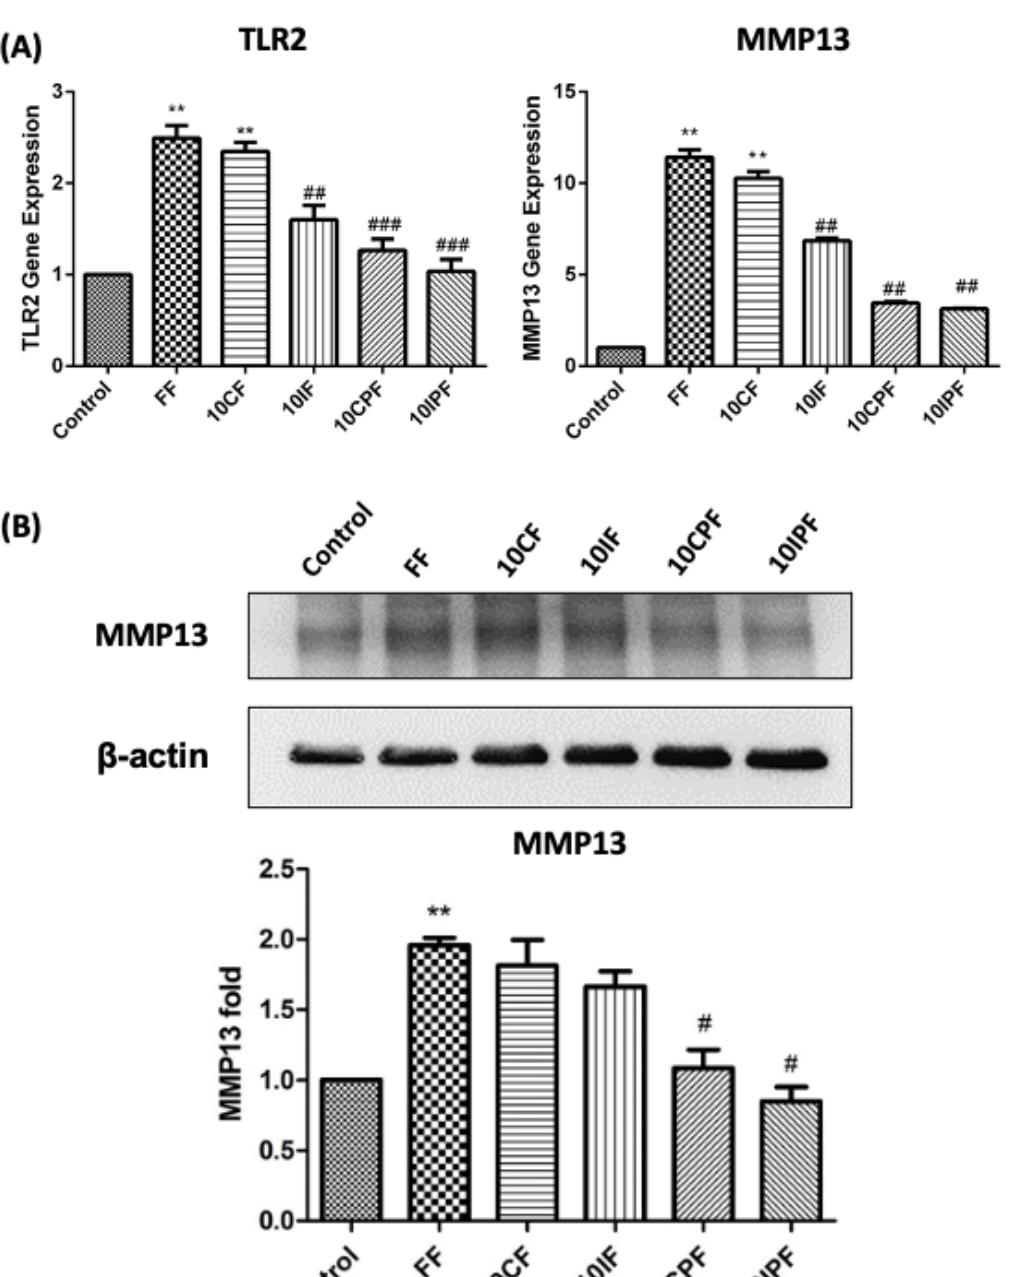
Figure 4. Effects of PRP on MMP-13 regulation associated with TLR2 pathway in chondrocyte cell line. We used 10 × TLR2 peptide antagonist to test ( A ) TLR2 and MMP-13 gene regulation in chondrocyte cells. FF treatment and 10 × CF groups were significantly higher compared with control groups. The 10 × CFP and 10 × IPF groups were significantly lower compared with FF groups. ( B ) Representative Western blotting indicates the effects of FF incubated with inhibitor peptide and PRP. Cotreatment with 10IPF resulted in MMP-13 expression far below that of the FF groups. All data are presented as the mean ± SD. The Student’s t -test was used to compare statistical differences among the following groups: FF groups and 10CF groups were compared with control values; 10IF groups, 10CPF groups, and 10IPF groups were compared with FF groups (FF: 30 KDa fibronectin fragment, CF: Control peptide; IF: Inhibitor peptide, CPF: Control peptide + PRP + FF; IPF: Inhibitor peptide + PRP + FF); n = 5 for each group; ** p < 0.05, # p < 0.05, ## p < 0.01, ### p < 0.001.